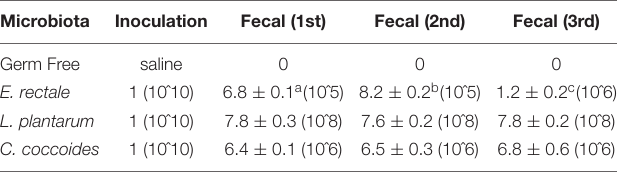
TABLE 1 | The microbiota colonization in indicated gnotobiotic animals. Microbiota